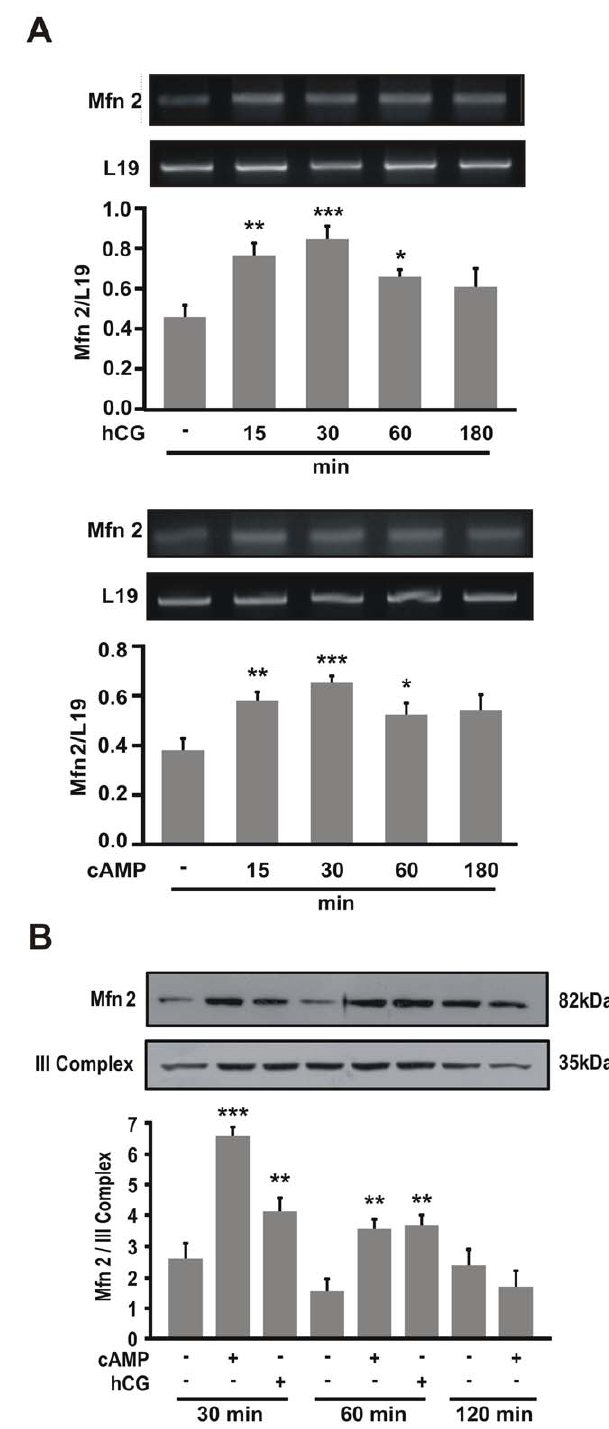
Figure 8. Hormonal stimulation induces Mfn2 expression. MA- 10 cells were treated with or without hCG (20 ng/ml) or 8Br-cAMP (1 mM) for the indicated times. A. Total RNA was isolated; reverse- transcribed, and subjected to semi-quantitative PCR using specific primers for Mfn2 and L19 cDNA as loading controls. PCR products were resolved in ethidium bromide-stained agarose gels. The figure shows representative gels. For each band, the OD of the expression levels of Mfn2 was quantified and normalized to the corresponding L19 abundance. The relative levels of Mfn2 are shown. The results are expressed as the means 6 SEM of three independent